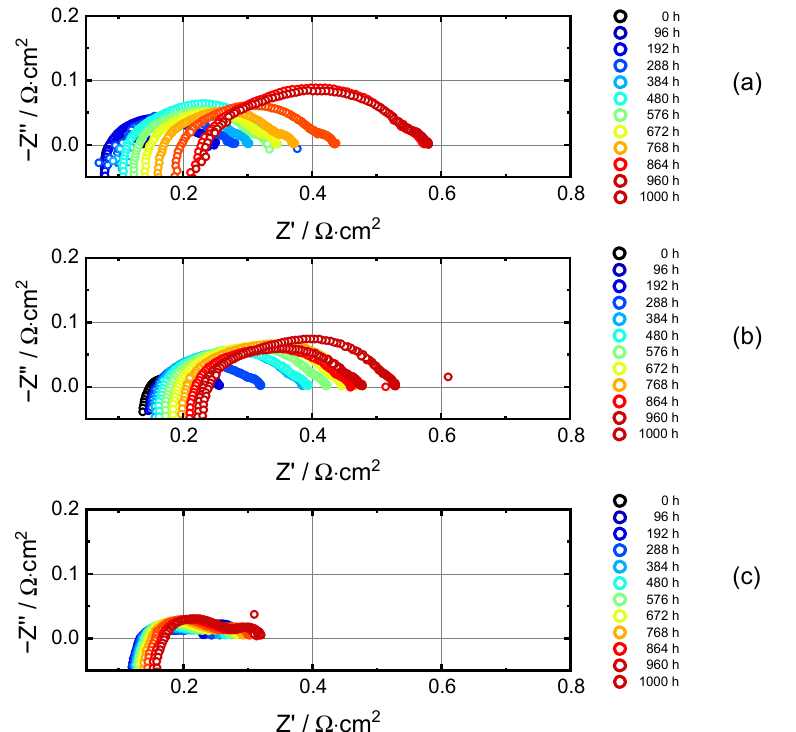
Figure 4. Intermitted EIS measurements with the single cells at OCV from 0 h to 1000 h with 9 L · h − 1 fuel consisting of ( a ) 50% H 2 + 50% H 2 O at 800 °C and ( b ) 50% H 2 + 50% H 2 O at 750 °C and ( c ) 40% H 2 O + 40% CO 2 + 20% H 2 at 800 °C.